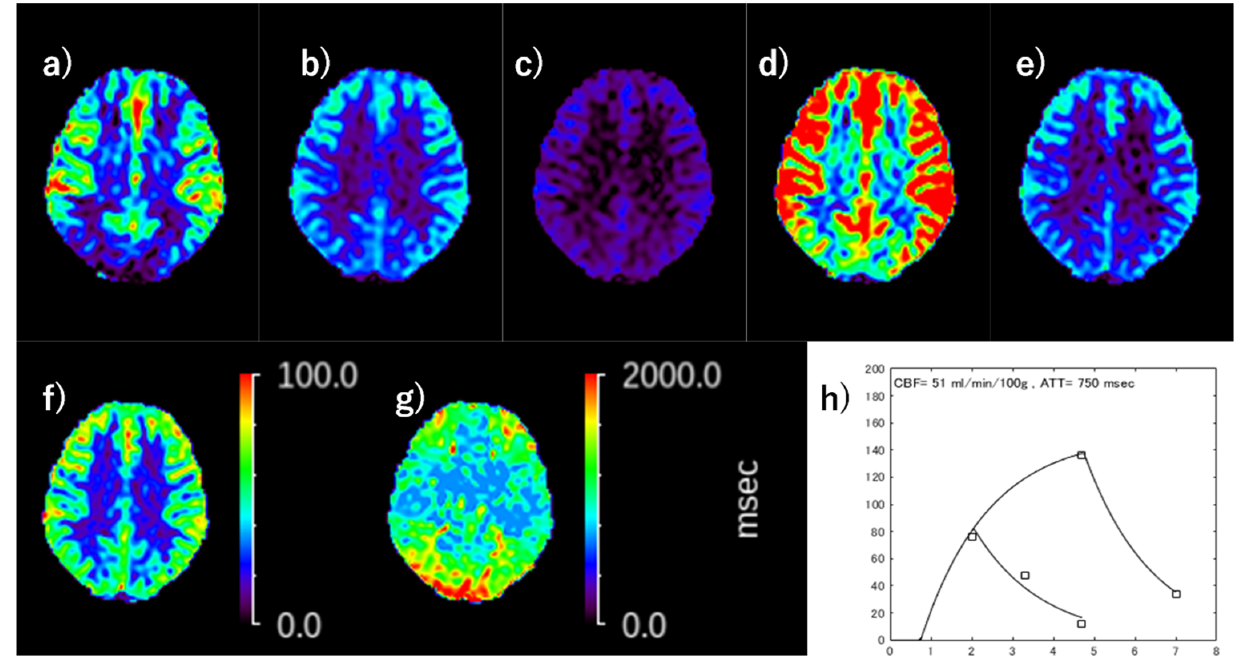
Figure 1. The calculation of ATT corrected ASL ‐ CBF using the combined Hadamard and long ‐ la ‐ beled long ‐ delay (LLLD) acquisitions. ( a ) Perfusion signal (  M/M 0 ) map of [LD, PLD] = [1.33, 0.7], labeled long-delay (LLLD) acquisitions. ( a ) Perfusion signal ( ∆ M / M 0 ) map of [LD, PLD] = [1.33, 0.7], ( b )  M/M 0 map of [LD, PLD] = [1.33, 2.03], ( c )  M/M 0 map of [LD, PLD] = [1.33, 3.36], ( d )  M/M 0 ( b ) ∆ M / M 0 map of [LD, PLD] = [1.33, 2.03], ( c ) ∆ M / M 0 map of [LD, PLD] = [1.33, 3.36], ( d ) ∆ M / M 0 map of [LD, PLD] = [4.0, 0.7], ( e )  M/M 0 map of [LD, PLD] = [4.0, 3.0], ( f ) ATT ‐ corrected CBF, ( g ) map of [LD, PLD] = [4.0, 0.7], ( e ) ∆ M / M 0 map of [LD, PLD] = [4.0, 3.0], ( f ) ATT-corrected CBF, ( g ) ATT map, ( h ) plots of each ∆ M / M 0 and the draw of selected least square solution. Plotted